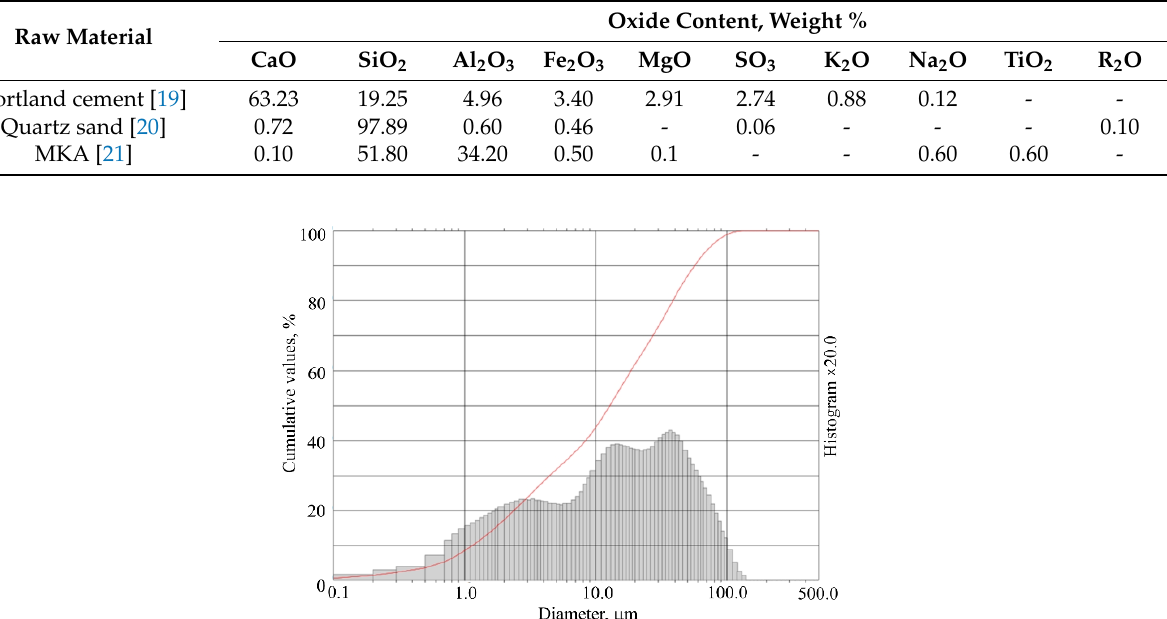
Table 1. Chemical composition of raw materials.